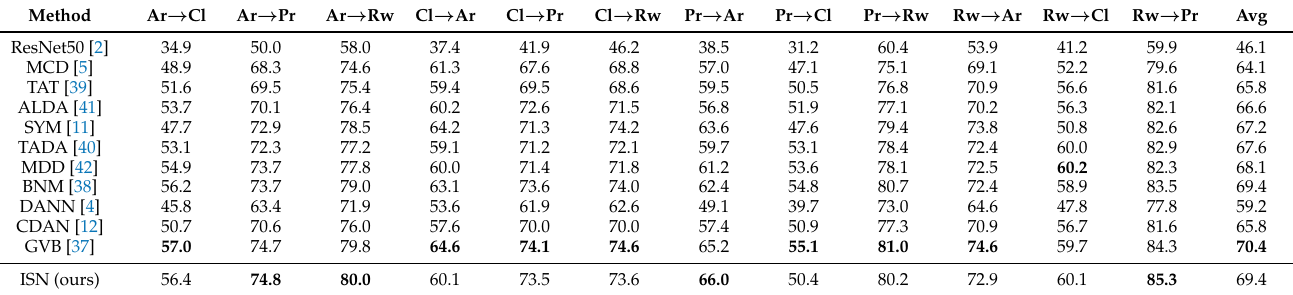
Table 5. Accuracy (%) on Office-Home.